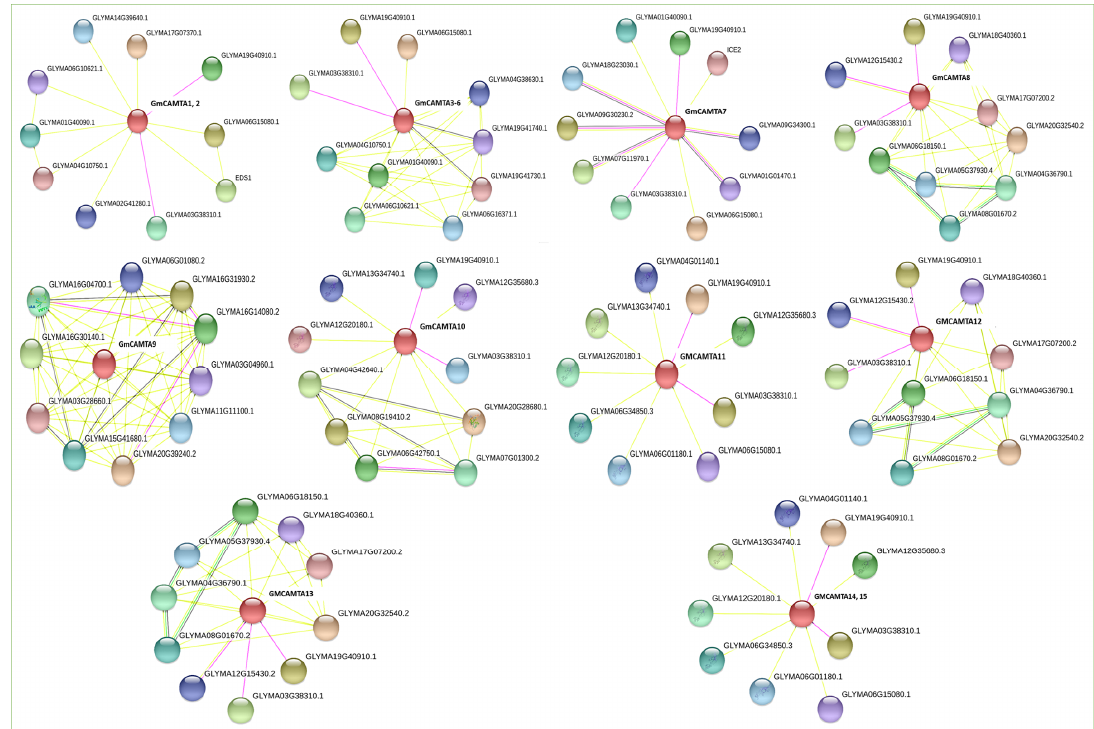
Figure 3. Protein-protein interaction network of GmCAMTAs detected in silico using the STRING database (https://string-db.org/). The experimentally determined interactions are denoted by pink strings, interactions on the basis of textmining are indicated by yellow strings while interactions on the basis of gene neighborhood shown by green strings.